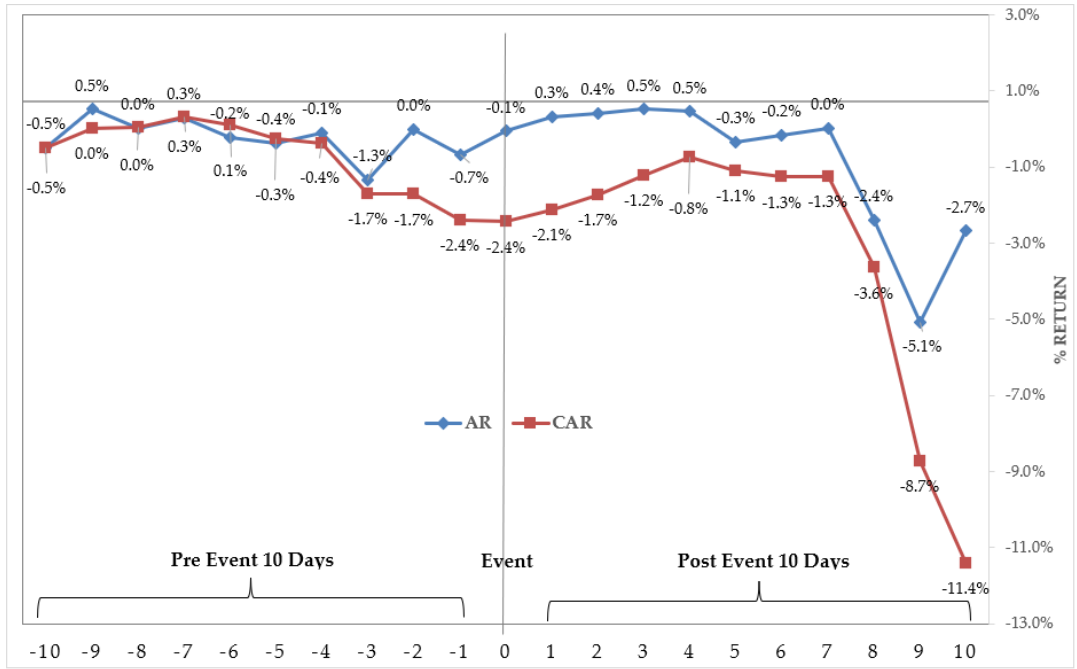
Figure 7. Abnormal returns and cumulative abnormal returns (MRPA method). In Figure 8, both the abnormal returns and cumulative abnormal returns are negative until day − 4. The abnormal returns remain positive until the day of the event, but then only become positive again on days 6 and 10. However, the cumulative abnormal returns are always negative.